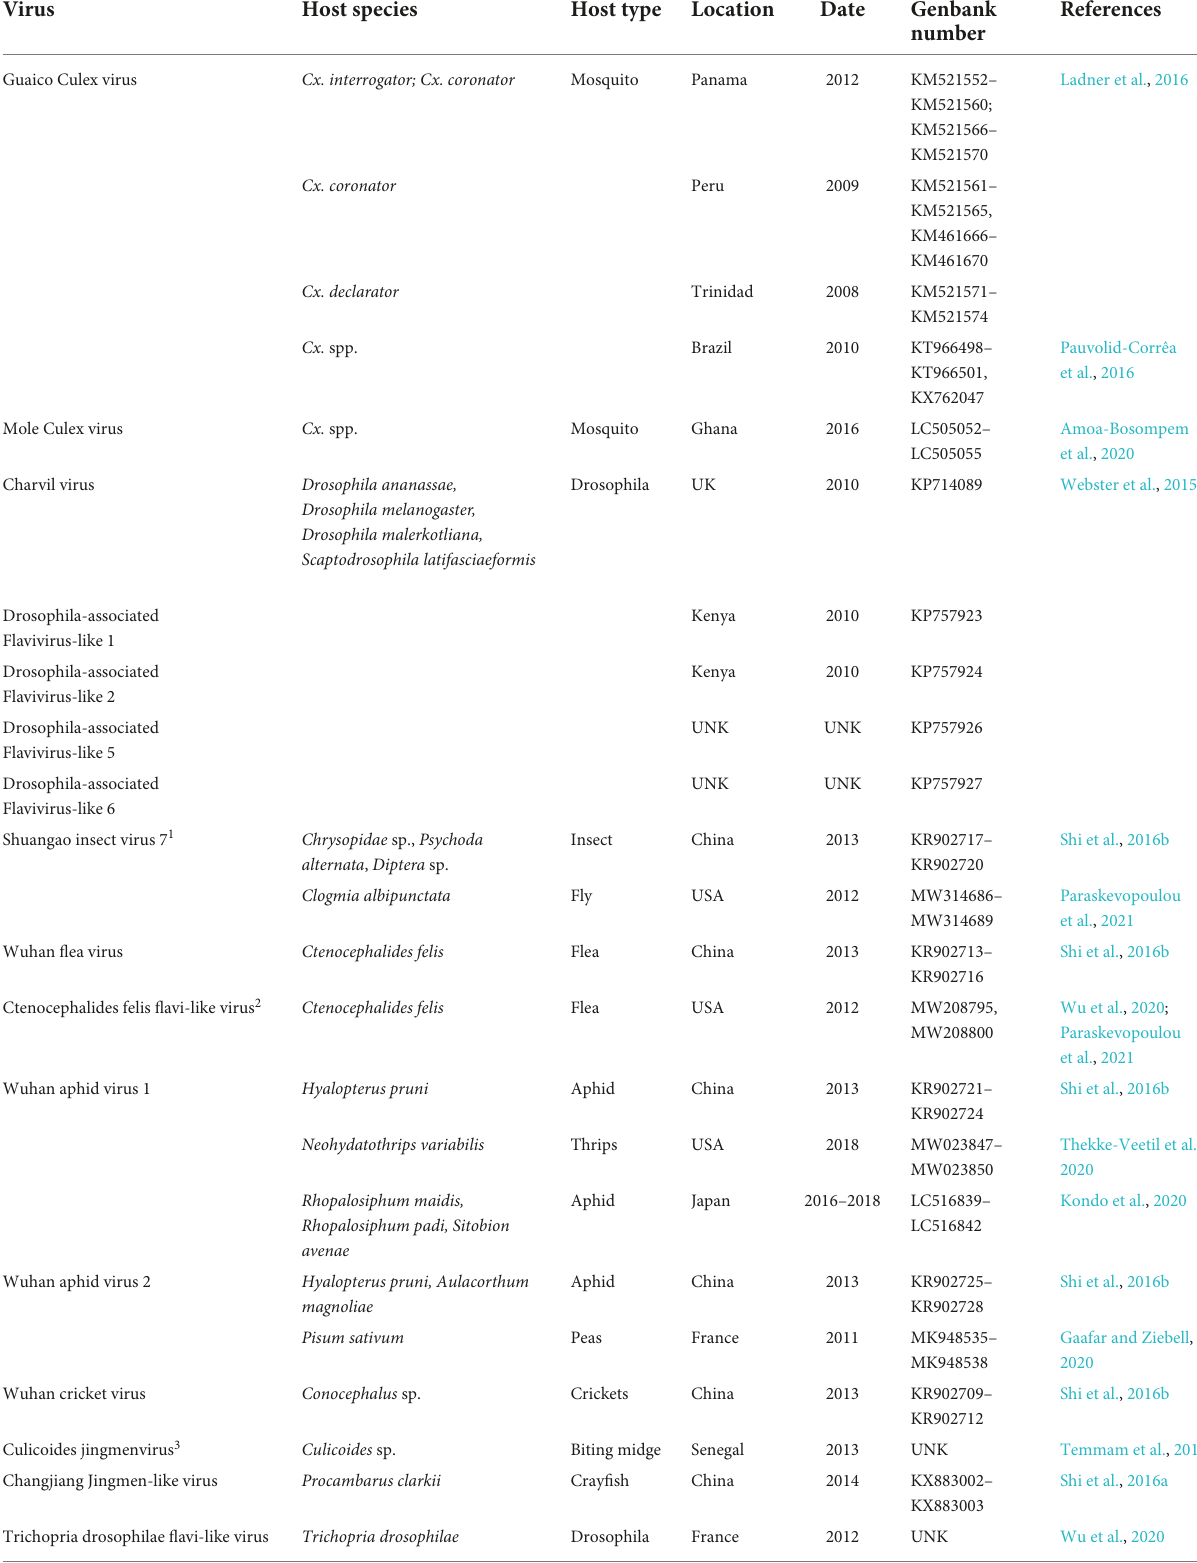
TABLE 2 Insect- and other host-associated jingmenviruses RNA